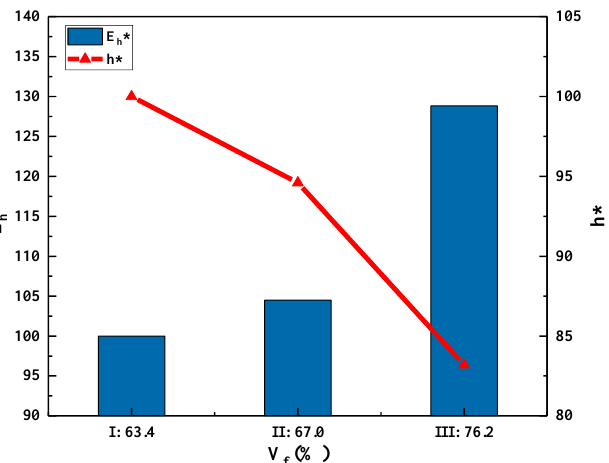
Figure 7. Experimental results of impact tests, E h *-V f and h*-V f . (Note: E h * and h* are normalized with the corresponding values of sample I).